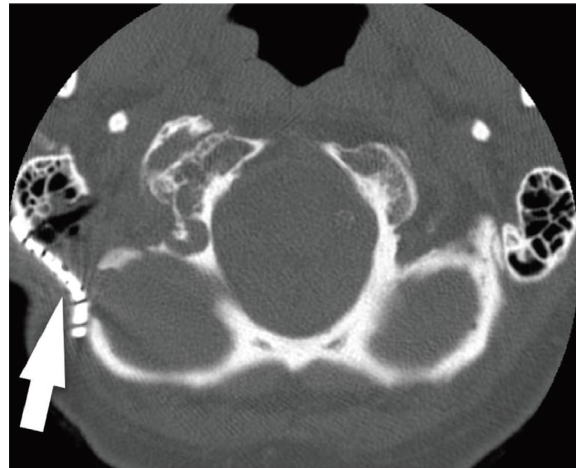
Figure 3: Axial CT image showing postoperative appearance. Te hypoglossal canal was decompressed laterally via partial mas- toidectomy, high cervical dissection, and partial resection of the occipital condyle. Metallic plating (arrow) covers the postoperative